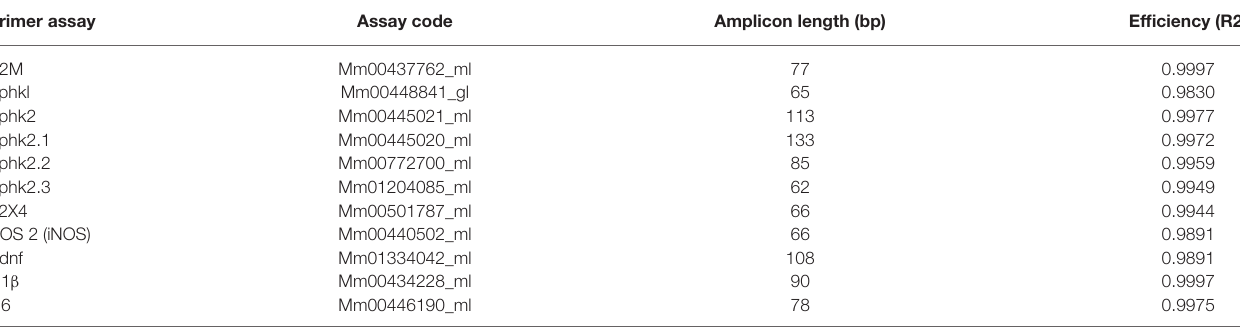
TABLE 1 | TaqMan primer assays.